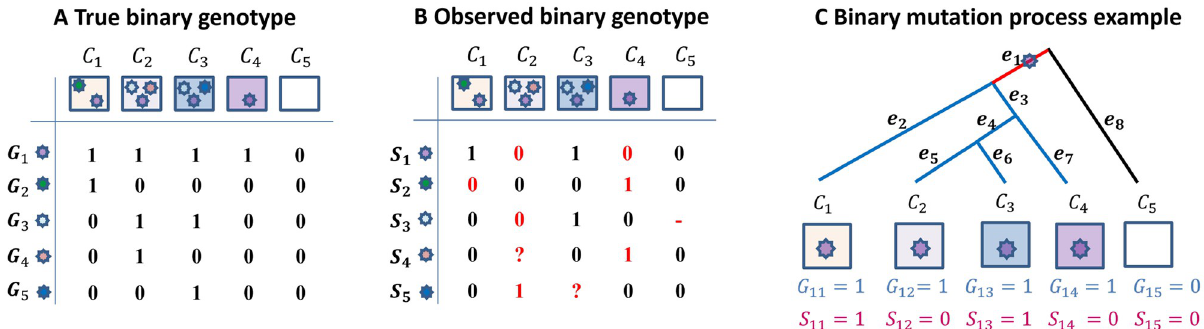
Fig 2. True binary data, observed binary data and binary mutation process example. (A) True binary mutation matrix of the sequenced tumor cells in the mutation tree in Fig 1E. Each row represents true genotypes for one genomic site in all cells and each column represents the true genotypes of multiple genomic sites for one single cell. (B) Observed mutation matrix with missing and ambiguous values (red), as well as mutation states that are misrecorded with respect to the true mutation matrix (red numbers; these are either false positives or false negatives). The red dash indicates a missing value since the sequencing process does not return signal at this site of this cell, and the red question mark represents an ambiguous value. Each row represents observed states for one genomic site in all cells and each column represents the observed states of multiple genomic sites for one single cell. (C) Binary mutation process example. A mutation is acquired on branch e 1 (highlighted in red). The cell descending from branch e 8 (highlighted in black) does not carry the mutation, while the cells descending from the blue branches carry the mutation.